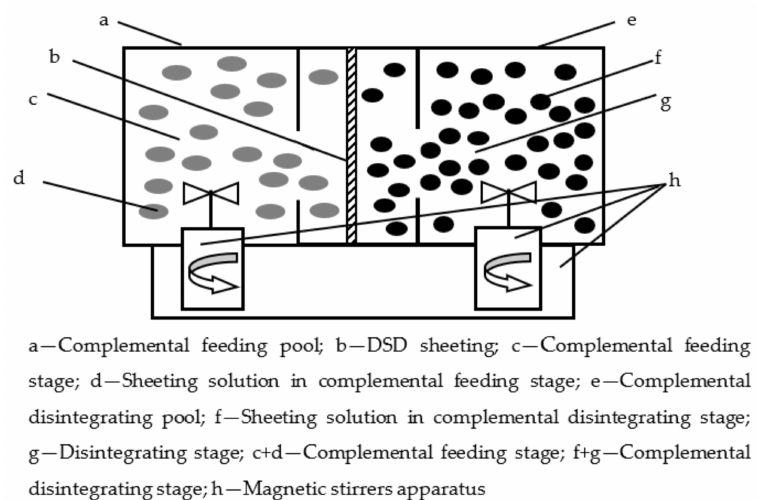
Figure 2. Experimental installation of DSD